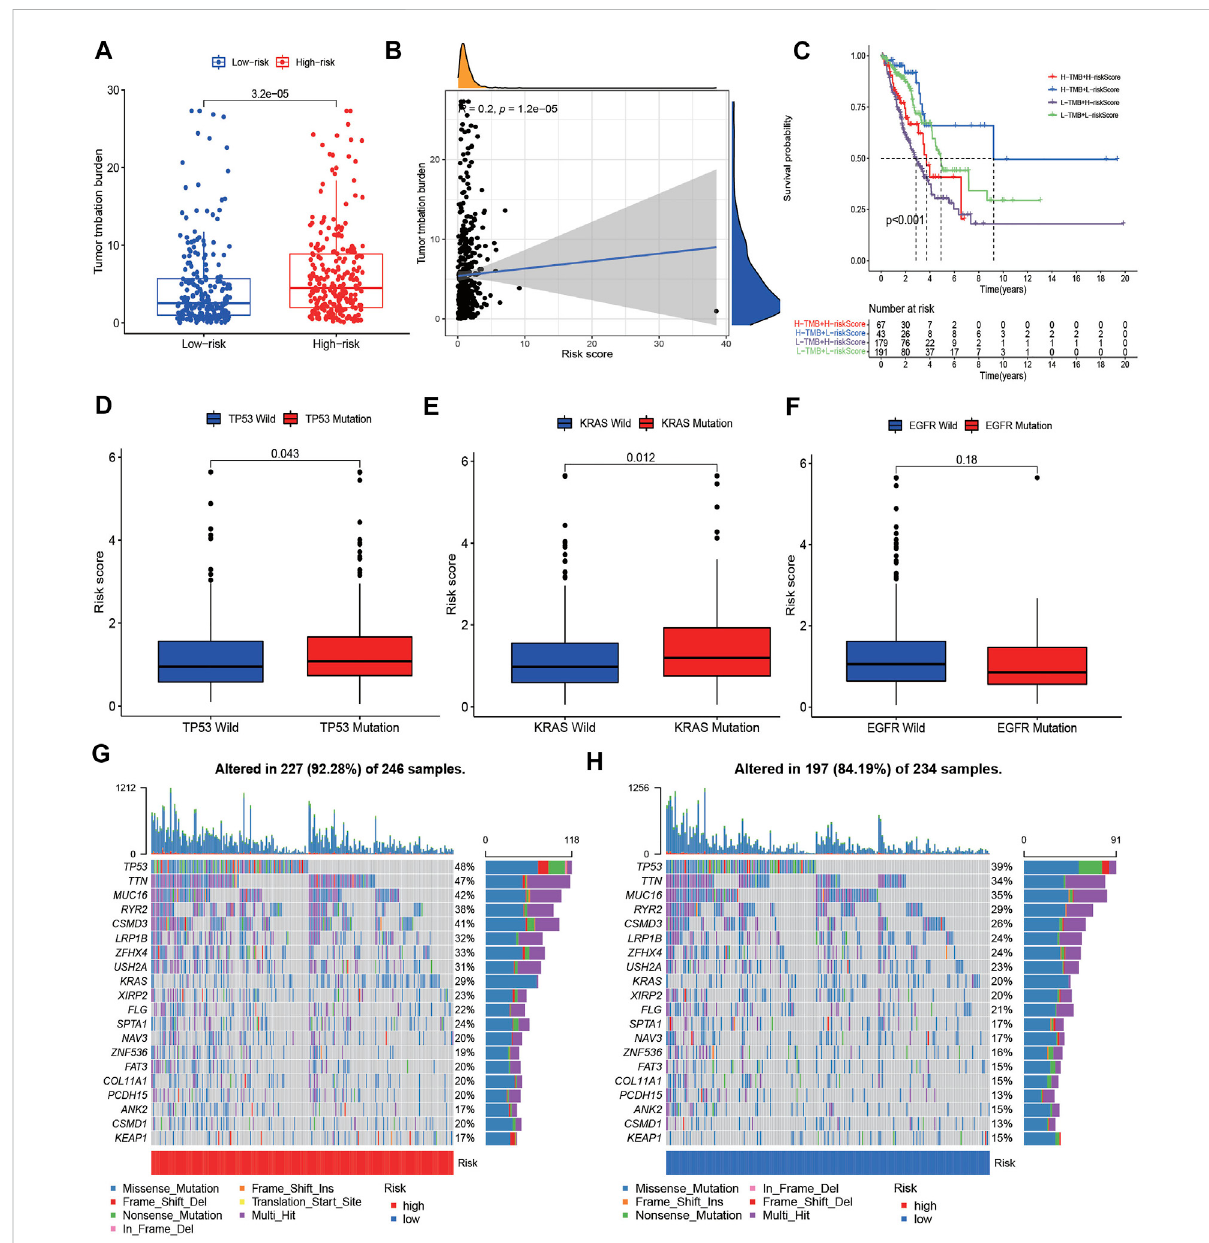
FIGURE 9 TheTMBlevelandSomaticmutationanalysisofriskscore. (A) Differencesoftumormutationburden(TMB)inthehigh-riskandlow-riskgroups. (B) Relationship between TMB and risk score. (C) Survival analysis between patients with high- and low-TMB. (C) Two-factor survival analyses of risk score and TMB levels. (D – F) Differences of risk score between different status of TP53, KRAS, and EGFR. (G,H) Landscape of top 20 mutated gene mutation pro fi les between high- and low-risk